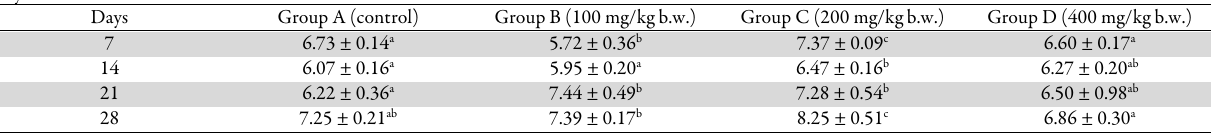
Table 3. Mean serum total protein (g/dl) levels (means ± standard error) of rat groups administered methanol fruit extract of Piper guineense for 28 days Days Group A (control) Group B (100 mg/kg b.w.) Group C (200 mg/kg b.w.) Group D (400 mg/kg